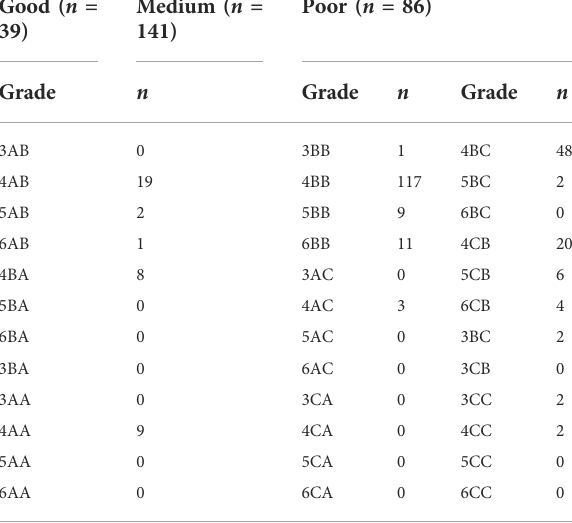
Since TE, ICM, and the degree of blastocyst expansion are important in morphological grades, we next explored their